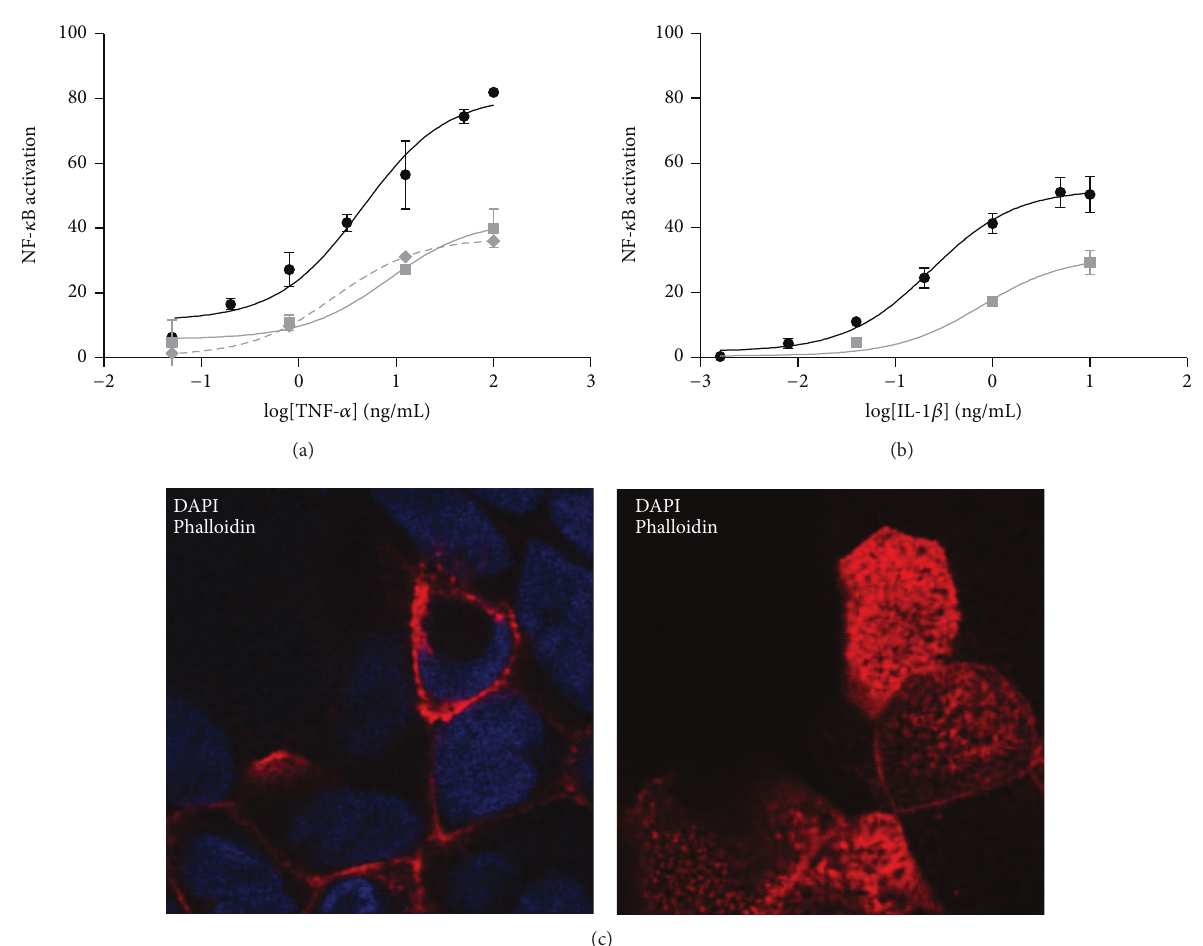
Figure 5: NF- 𝜅 B activation in polarized Caco-2-NF- 𝜅 B-hrGFP C3 clone cells. Polarized in plastic culture plates (grey continuous line), transwell filter (grey dotted line) and nonpolarized (black line) cells were stimulated during 48h with TNF- 𝛼 (a) or IL-1 𝛽 (b). For polarization in transwell filter, only TNF- 𝛼 was assayed and it was added in the basolateral chamber. Cells were trypsinized and GFP expression was analyzedbyflowcytometry.NF- 𝜅 Bactivationwasdeterminedaspreviouslydescribed.Caco-2-NF- 𝜅 B-hrGFPC3clonecellswerepolarizedfor 21 days and then fixed, permeabilized, and stained with Texas Red-X Phalloidin (for actin distribution, red) and DAPI (for nuclei localization, blue). All images were obtained through confocal microscopy. Representative cells of basal and apical membranes are shown in left and right images, respectively (c). Data was expressed as mean of triplicates with SD error